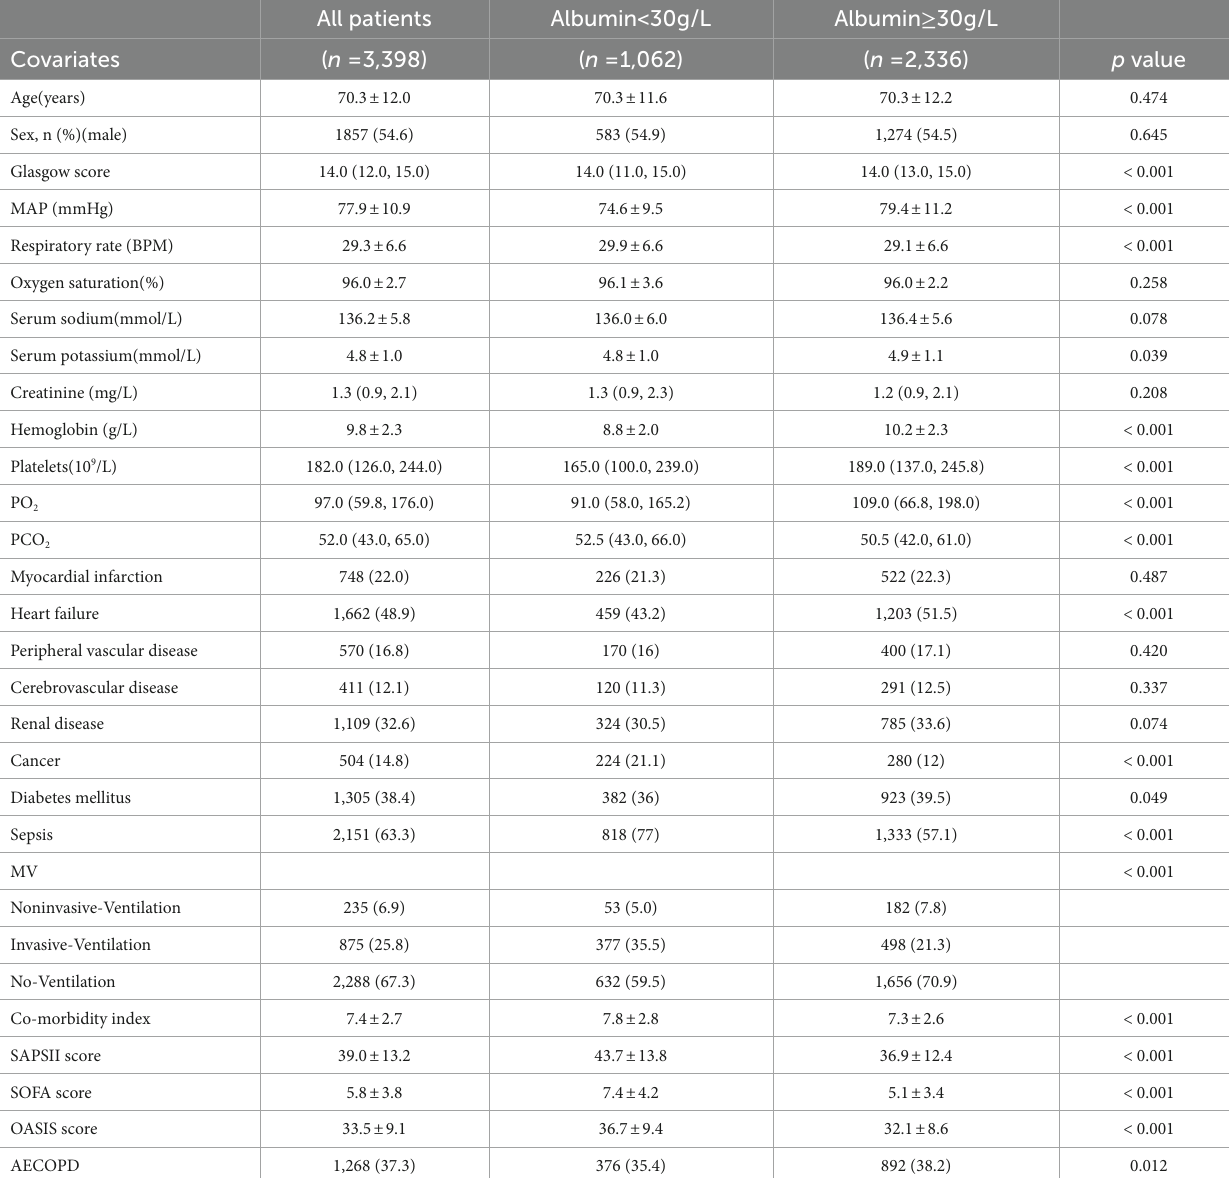
TABLE 1 Baseline characteristics of